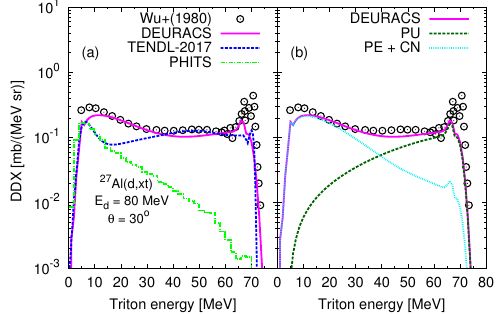
Figure 2. Same as figure 1 but for the 27 Al( d , xt ) reaction at 80 MeV. Experimental data are taken from Ref.